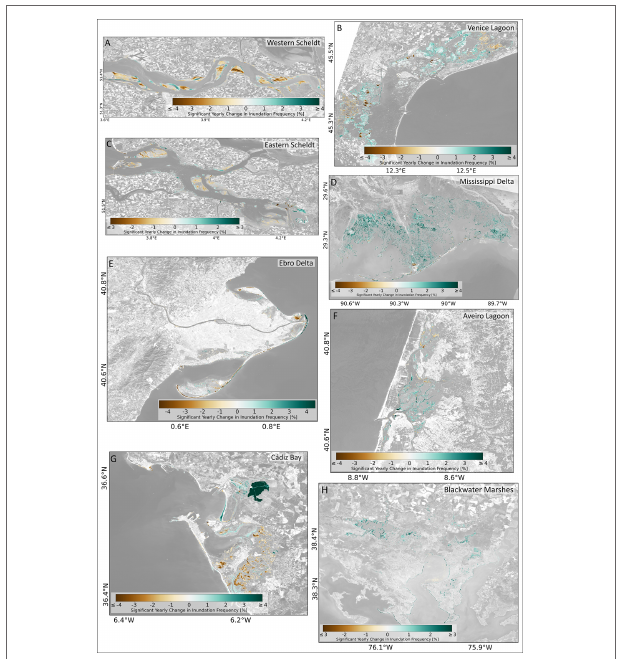
FIGURE 5 | Maps of significant yearly change in inundation frequency [%] for each of the eight selected study sites. The background of each map is grayscale Landsat 8 OLI imagery (background images courtesy of the U.S. Geological